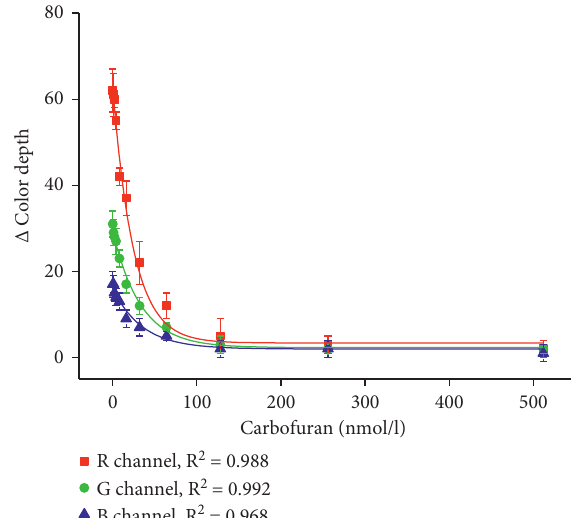
Figure 5: Calibration of colorimetric biosensor for carbofuran assay. The error bars indicate the standard error for five inde- pendent repeats ( n � 5).